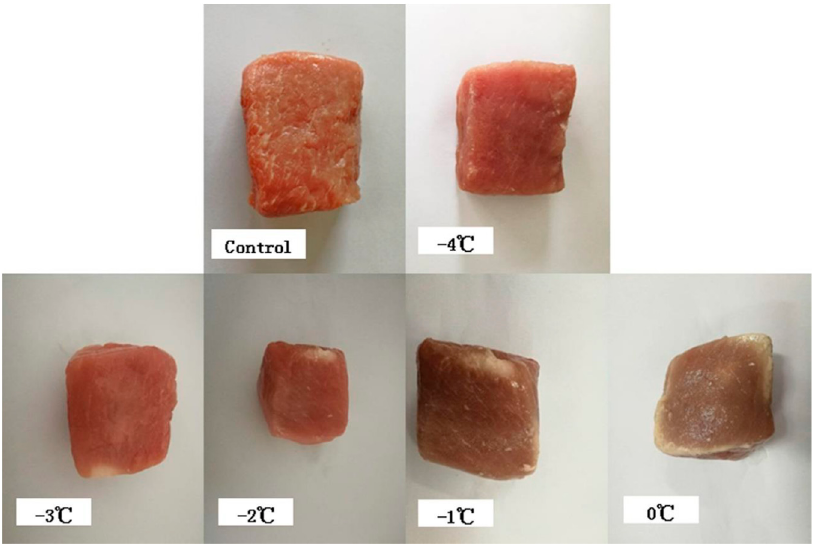
Figure 1. Localized overheating in pork samples thawed by microwave. Core temperatures were − 4 °C, − 3 °C, − 2 °C, and − 1 °C.